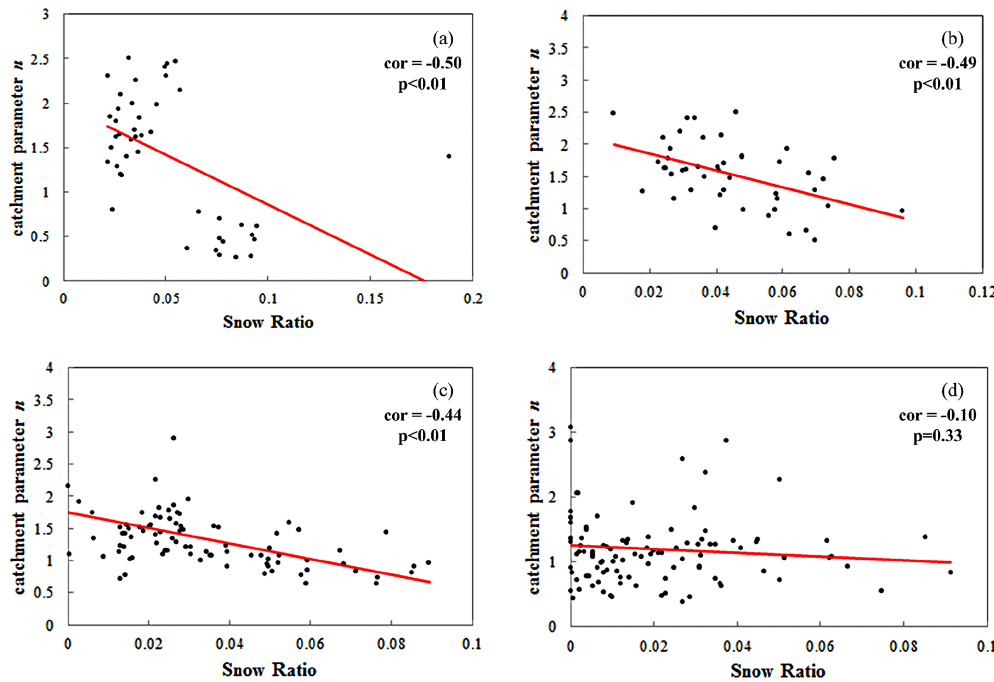
Figure 3. In the context of the Budyko–Choudhury framework, statistical relationships between the specific catchment parameter n and the snow ratio, under similar vegetation coverage. Least squares regression lines are shown on each of the plots. The Pearson’s linear correlation coefficient clarifies the significant negative correlation between snow ratio and catchment parameter. (a–d) indicate the vegetation coverage of < 0.3, (0.3, 0.4), (0.4, 0.5), and > 0.5, respectively.